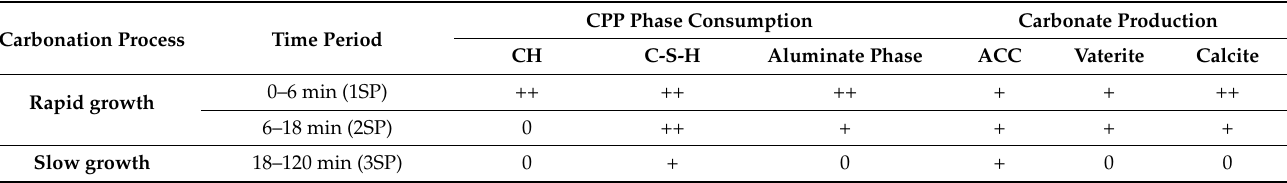
Table 2. Qualitative variation in the main phases of CPP during the carbonation